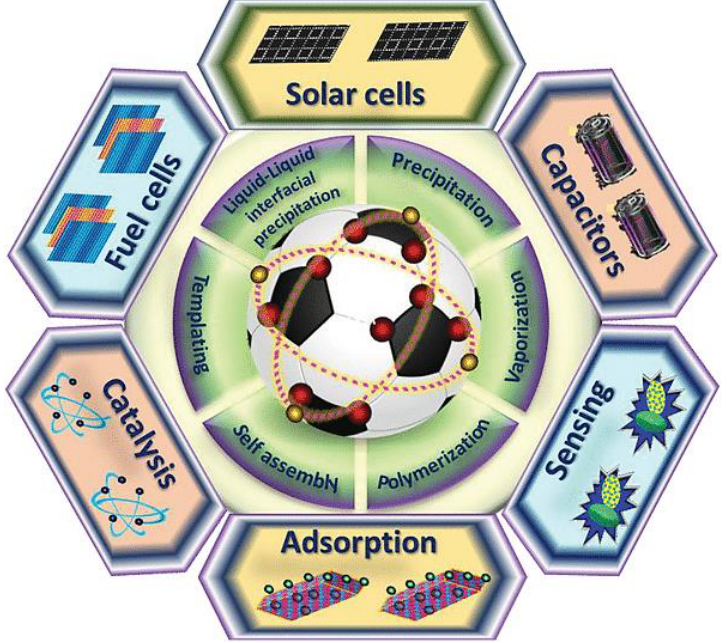
Figure 2. Synthesis, functionalization, and application of fullerene [48]. Reproduced with permission from Wiley.